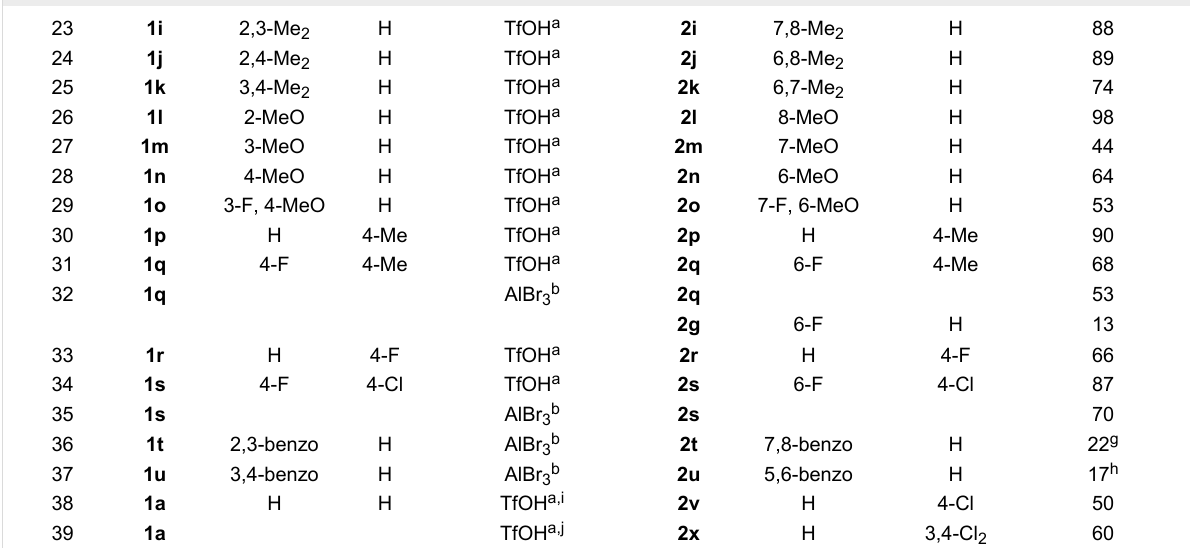
Table 1: Reactions of amides 1a–u with benzene (and other arenes) under superelectrophilic activation, leading to dihydroquinolinones 2a–x . (continued)